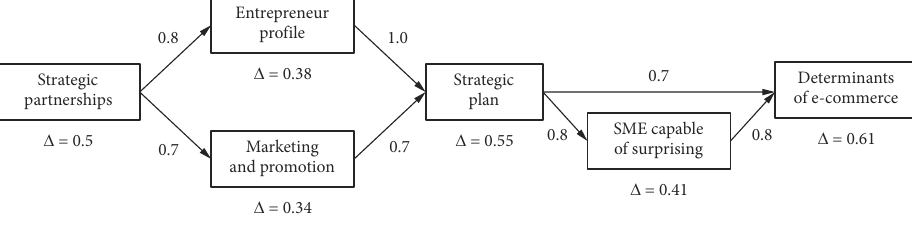
Figure 9. Impact of variation on strategic partnerships